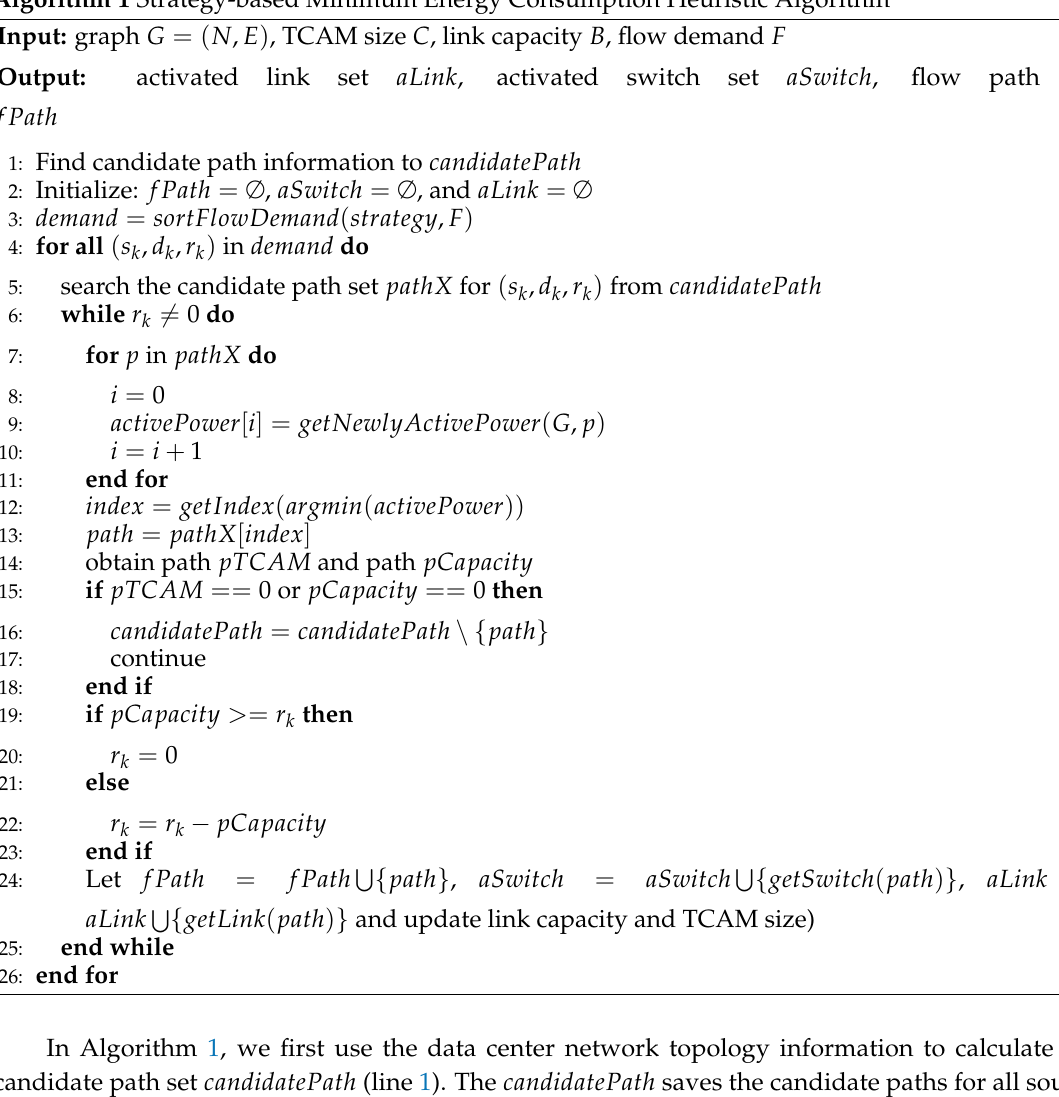
Algorithm 1 Strategy-based Minimum Energy Consumption Heuristic